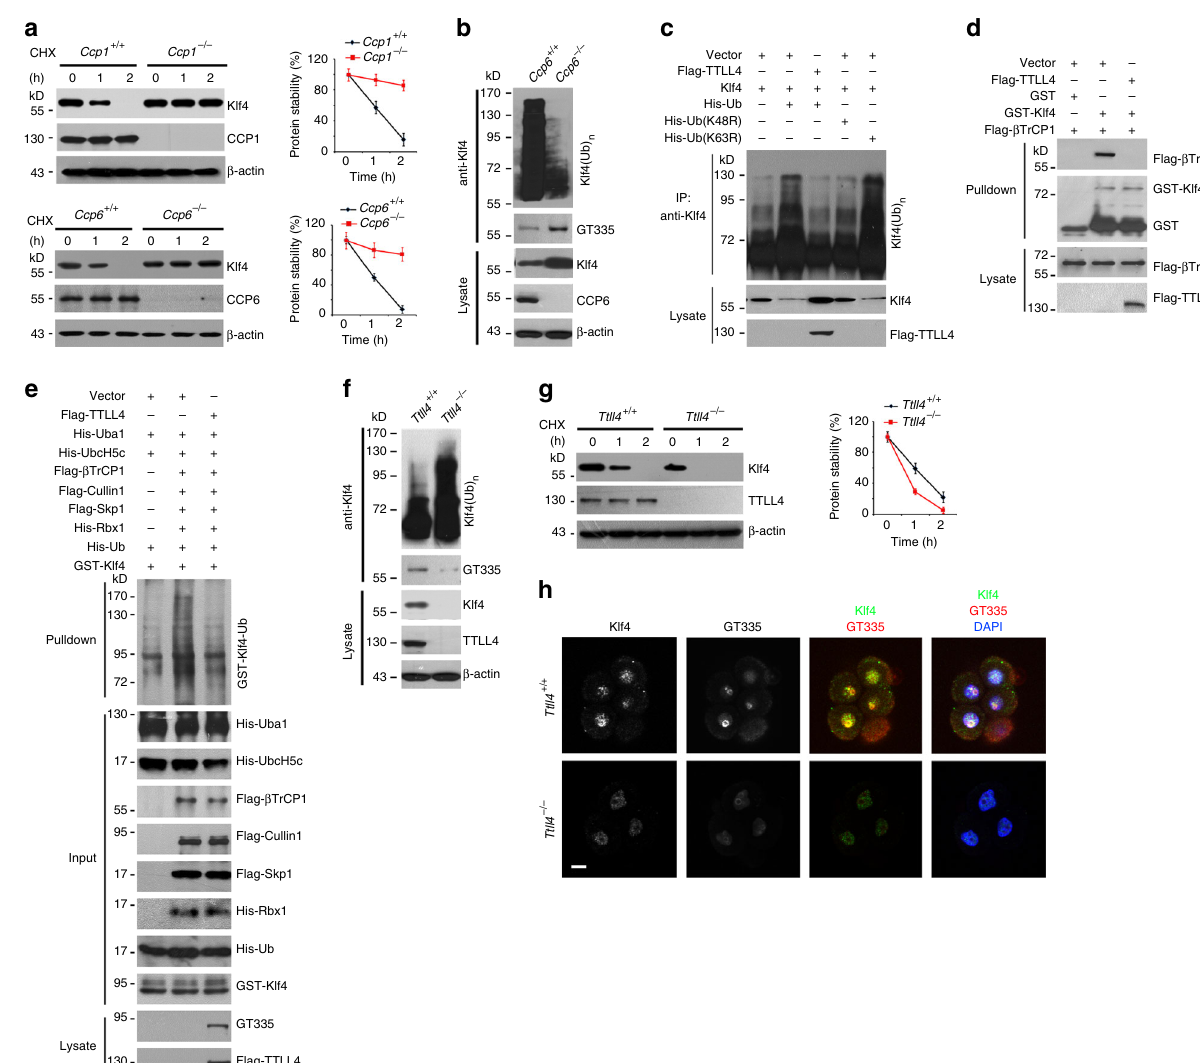
Fig. 4 Klf4 glutamylation impedes K48-linked ubiquitination to sustain its stability. a Ccp1 - and Ccp6 -de fi cient MEFs were treated with cycloheximide (CHX) (20 μ g/ml) for the indicated time and followed by immunoblotting. Percentage of residual protein levels was counted as means ± S.D. b Ccp6 + / + or Ccp6 − / − MEFs were transfected by OSKM for 2 days and treated with MG132 (10 μ M) for 4 h. Cells were collected and immunoprecipitated with anti-Klf4 antibody followed by detection with anti-poly-Ub antibody. c Klf4 ubiquitination is K48-linked but not K63-linked. pMX5-Klf4 together with pCDNA4- MycHis-Ubiquitin (Ub) or Ub(K48R), Ub(K63R) mutant were transfected into 293T cells for 48 h and analyzed as in b . d rGST-Klf4 was pre-incubated with lysates from 293 T cells transfected with Flag-TTLL4 at 37 °C for 2 h, followed by GST pulldown with Flag- β TrCP1 and immunoblotting with indicated antibodies. e rGST-Klf4 was pre-incubated with lysates from 293T cells transfected with Flag-TTLL4 at 37 °C for 2 h. Klf4 protein was then incubated with recombinant active ERK1 (Millipore) and 2 mM ATP at 30 °C for 30 min. His-tagged E1 (Uba1), E2 (UbcH5c), ubiquitin, Rbx, Flag-tagged β TrCP1, Skp1, Cullin1 and GST-tagged Klf4 were incubated for the in vitro ubiquitination reconstitution assay at 30 °C for 2 h. Ubiquitinated Klf4 was probed by anti-GST antibody. f TTLL4 de fi ciency promotes the ubiquitination of Klf4 in OSKM-induced MEFs. Ttll4 + / + or Ttll4 − / − MEFs was transfected by OSKM for 2 days and assessed for ubiquitination as described in b . g Ttll4 -de fi cient MEFs were treated with cycloheximide (CHX) (20 μ g/ml) for the indicated time, followed by immunoblotting as described in a . h Ttll4- de fi cient 4- to 8-cell stage embryos were isolated and immunostained with anti-Klf4 and GT335 antibodies. Scale bar, 20 μ m.For Ttll4 +/+ embryos, n = 67. For Ttll4 − / − embryos, n = 55. All data are representative of four independent